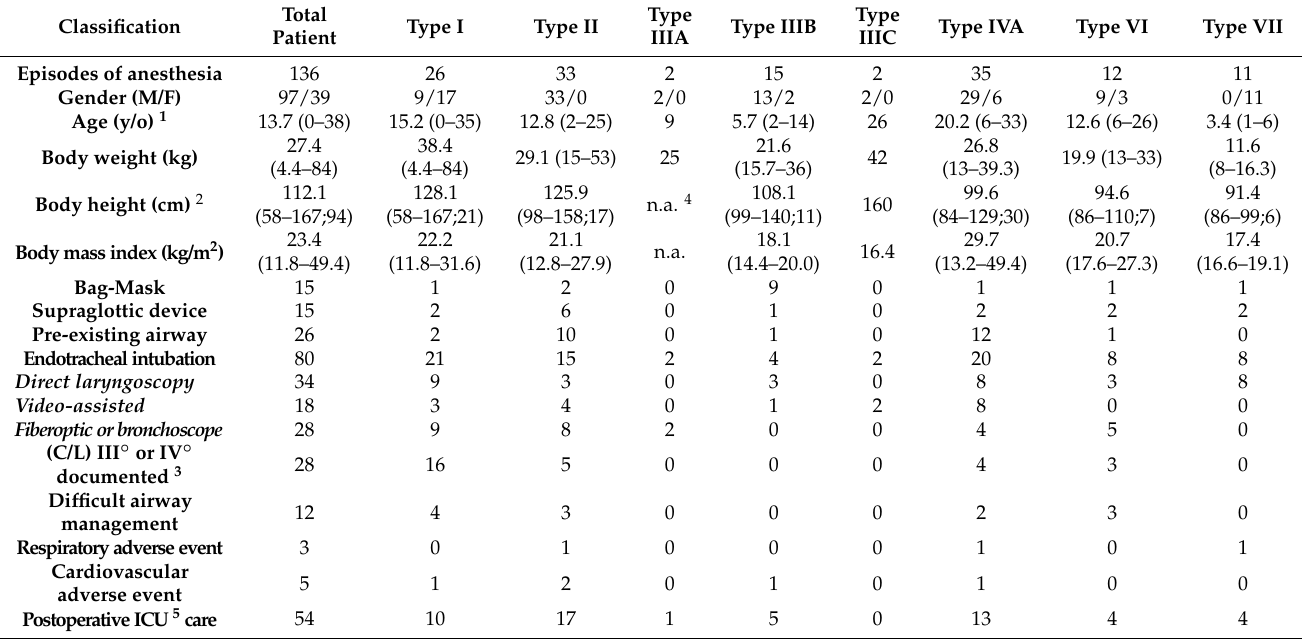
Table 2. General anesthesia and patients’